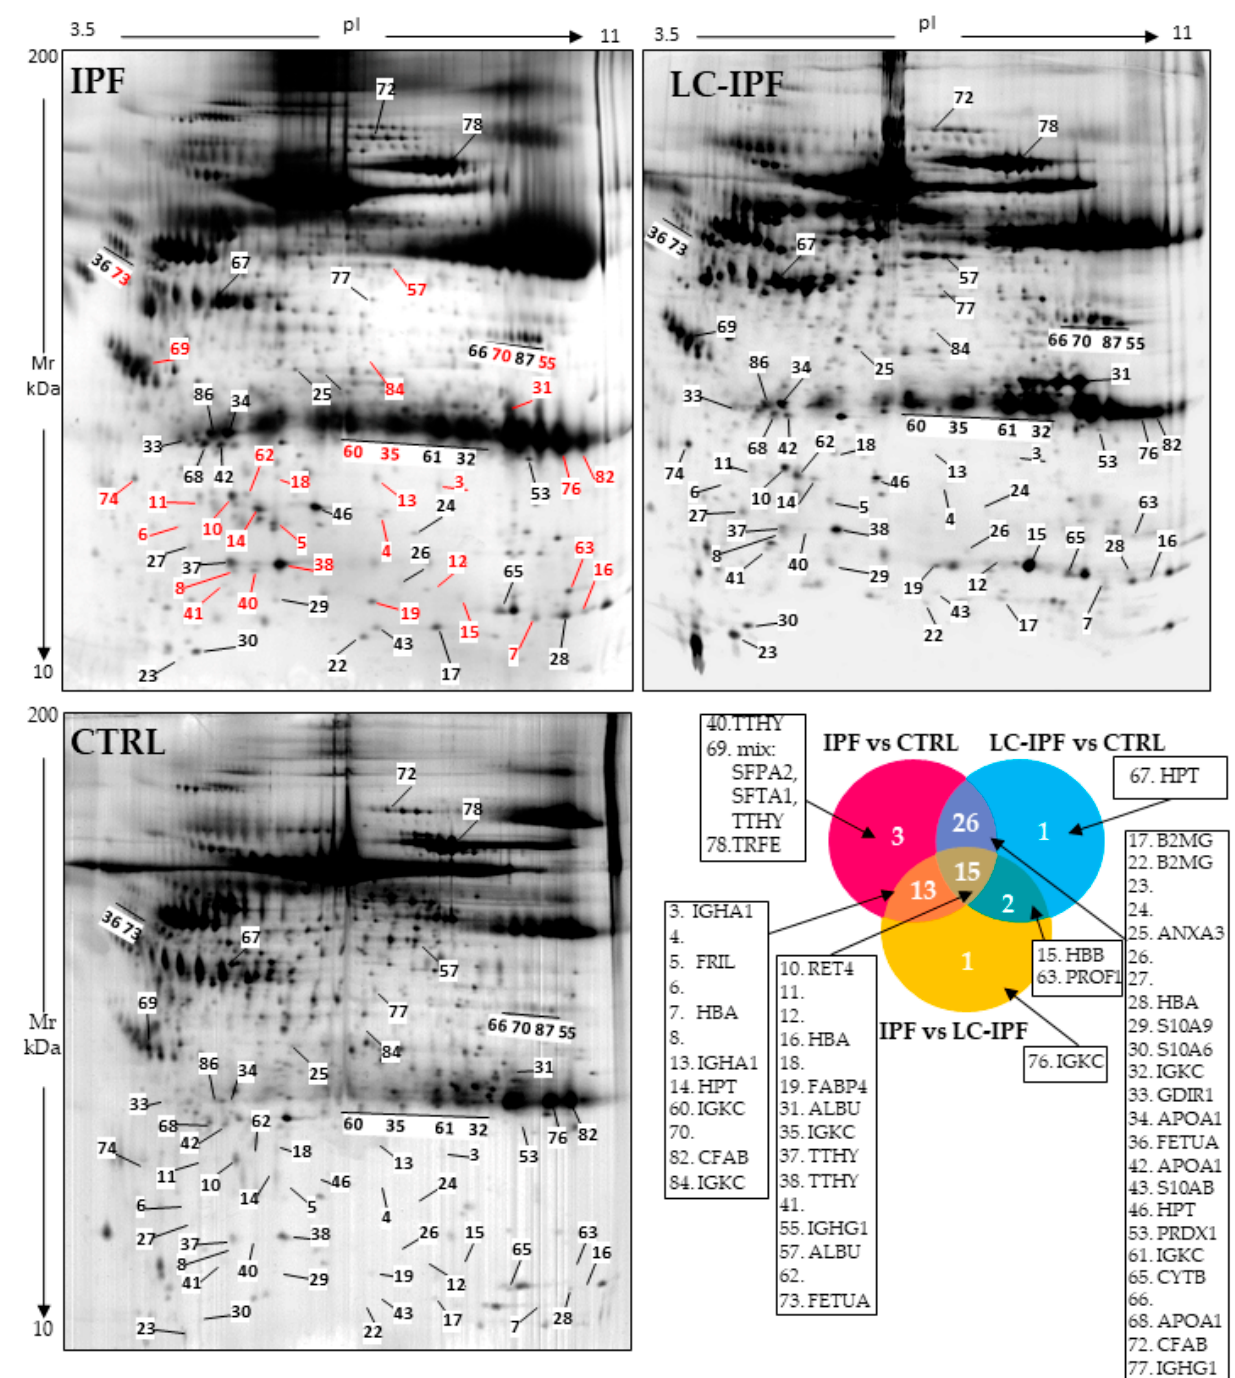
Figure 1. IPF, LC-IPF, and CTRL BALF reference gel maps reporting the statistically relevant spots with a fold change ratio ≥ 1.8. Red spots represent differences between IPF and LC-IPF. Moreover, Venn diagram shows 13 overlapping proteins between the IPF vs. LC-IPF and IPF vs. CTRL comparisons; 2 overlapping proteins between the LC-IPF vs. CTRL and IPF vs. LC-IPF comparisons; 26 overlapping proteins between the IPF vs. CTRL and LC-IPF vs. CTRL comparisons; and 15 over- lapping proteins among the three comparisons. Only one protein was exclusively associated with IPF vs. LC-IPF and IPF vs. CTRL comparisons. Relative proteins are reported in the side